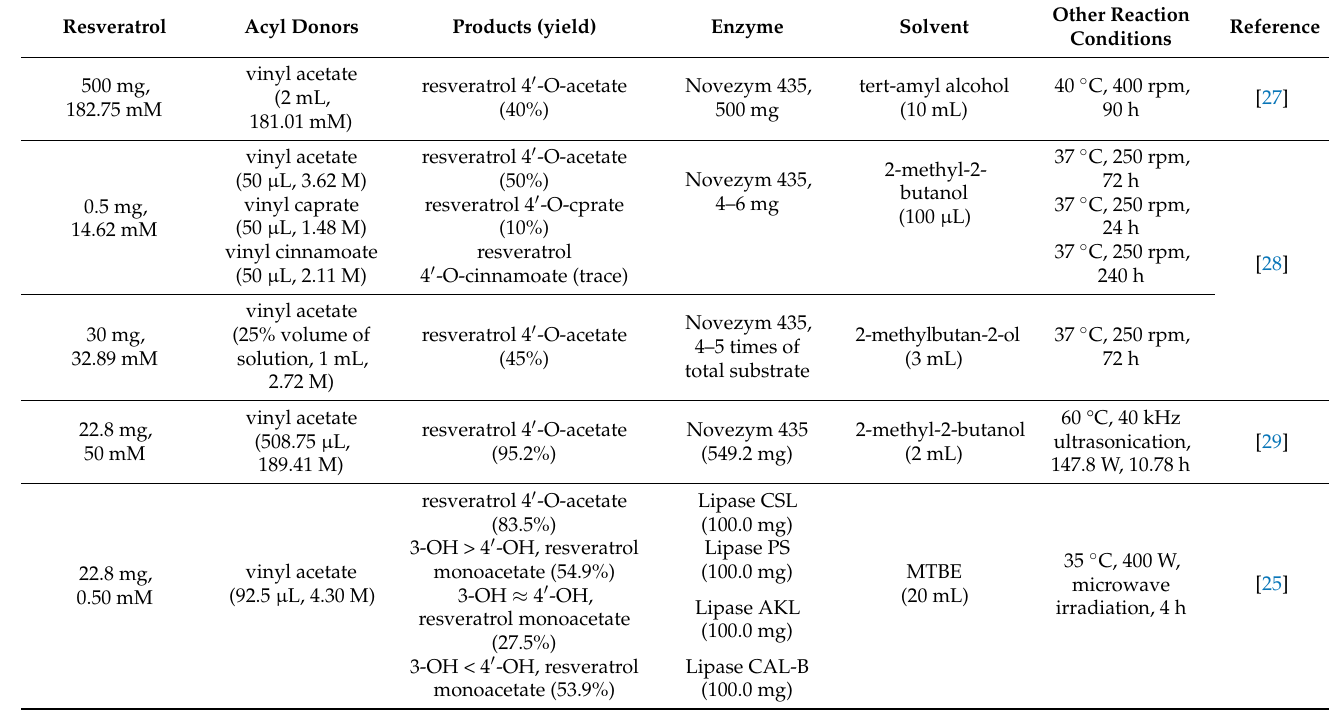
Table 1. General reaction conditions and yields of enzymatically synthesized resveratrol